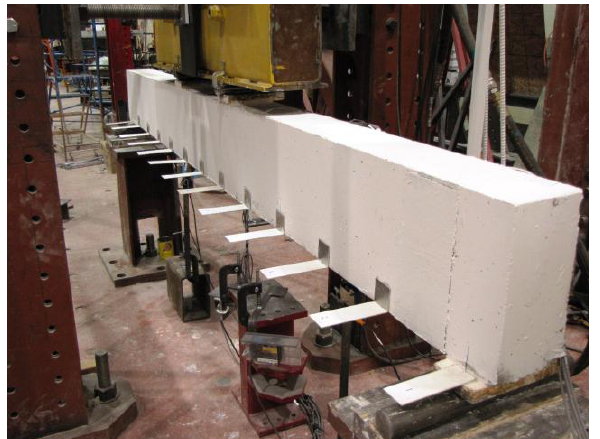
Figure 2. Concrete beam to be used for the experiment (placed underneath the spreader beam)